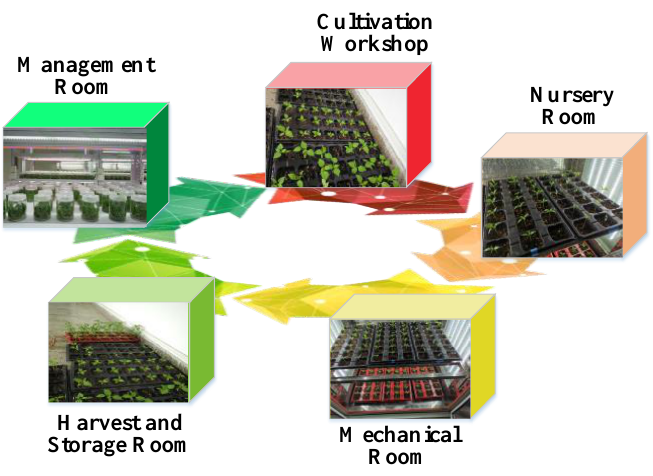
Figure 1. Spatial structure of the plant factory .